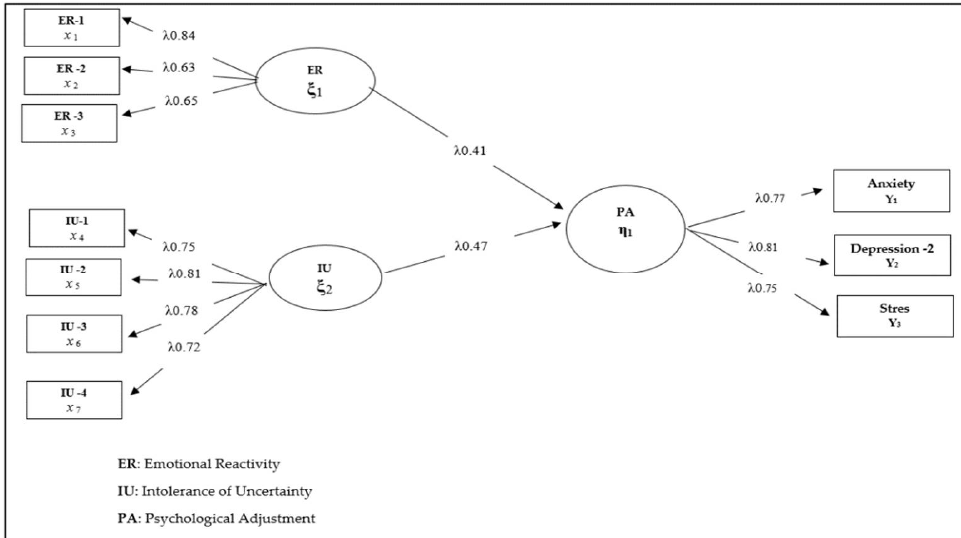
Figure 1. Standardized SEM results for Model 1 . (Figure S1).